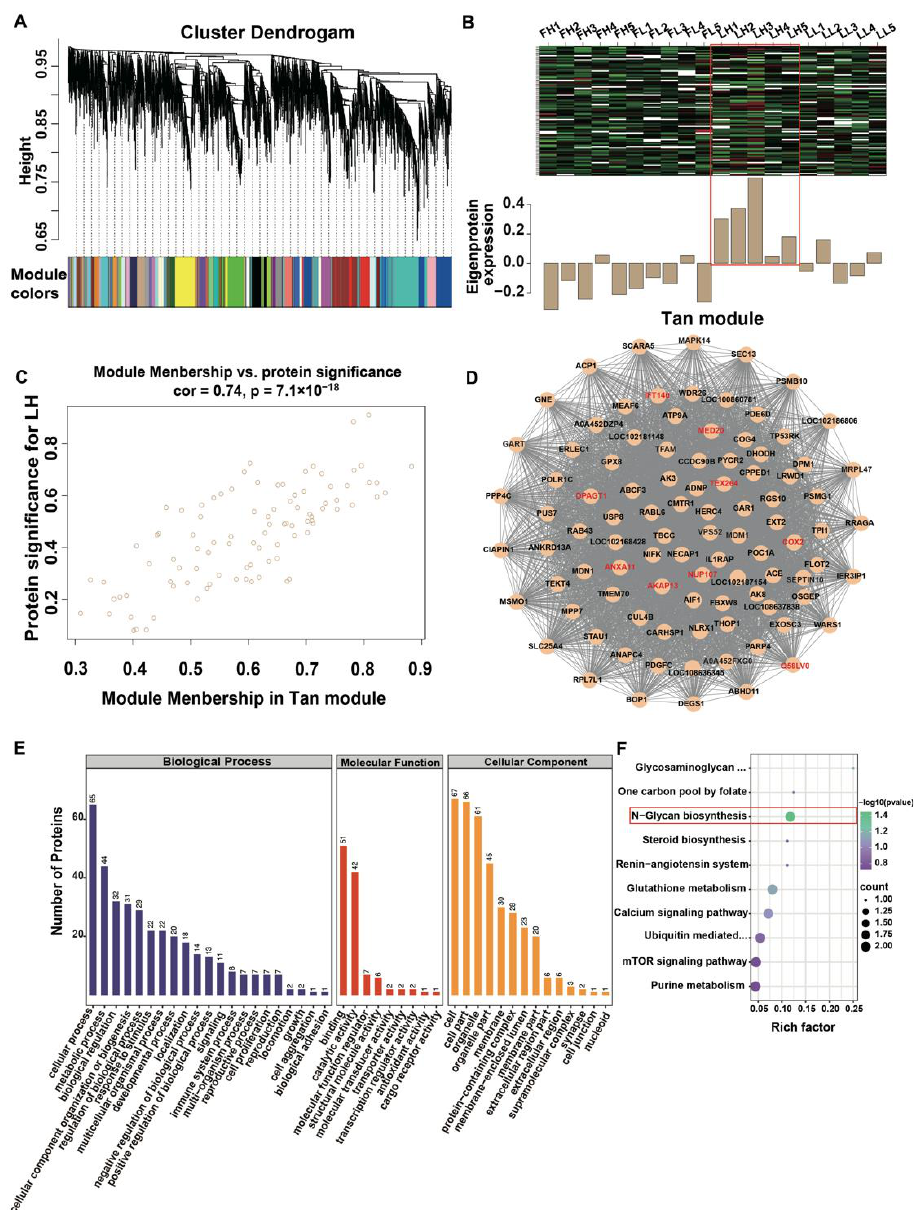
Figure 2. Protein co-expression network analysis of the oviduct proteome identified modules associated with high fecundity. ( A ) Module colors represent the final modules. Each branch in the hierarchical tree or each vertical line in the color bars represents one protein. ( B ) Eigengene expression pattern of the tan module. ( C ) A scatterplot of proteins significance for high fecundity in the luteal phase (LH) vs. module membership in the tan module. ( D ) The co-expressed protein network of the tan module. ( E ) GO analysis of Tan module proteins. The vertical coordinate indicates the GO Level 2 annotation information, including Biological Process, Molecular Function, and Cellular Component; the horizontal coordinate indicates the number of DAPs under each functional category. ( F )